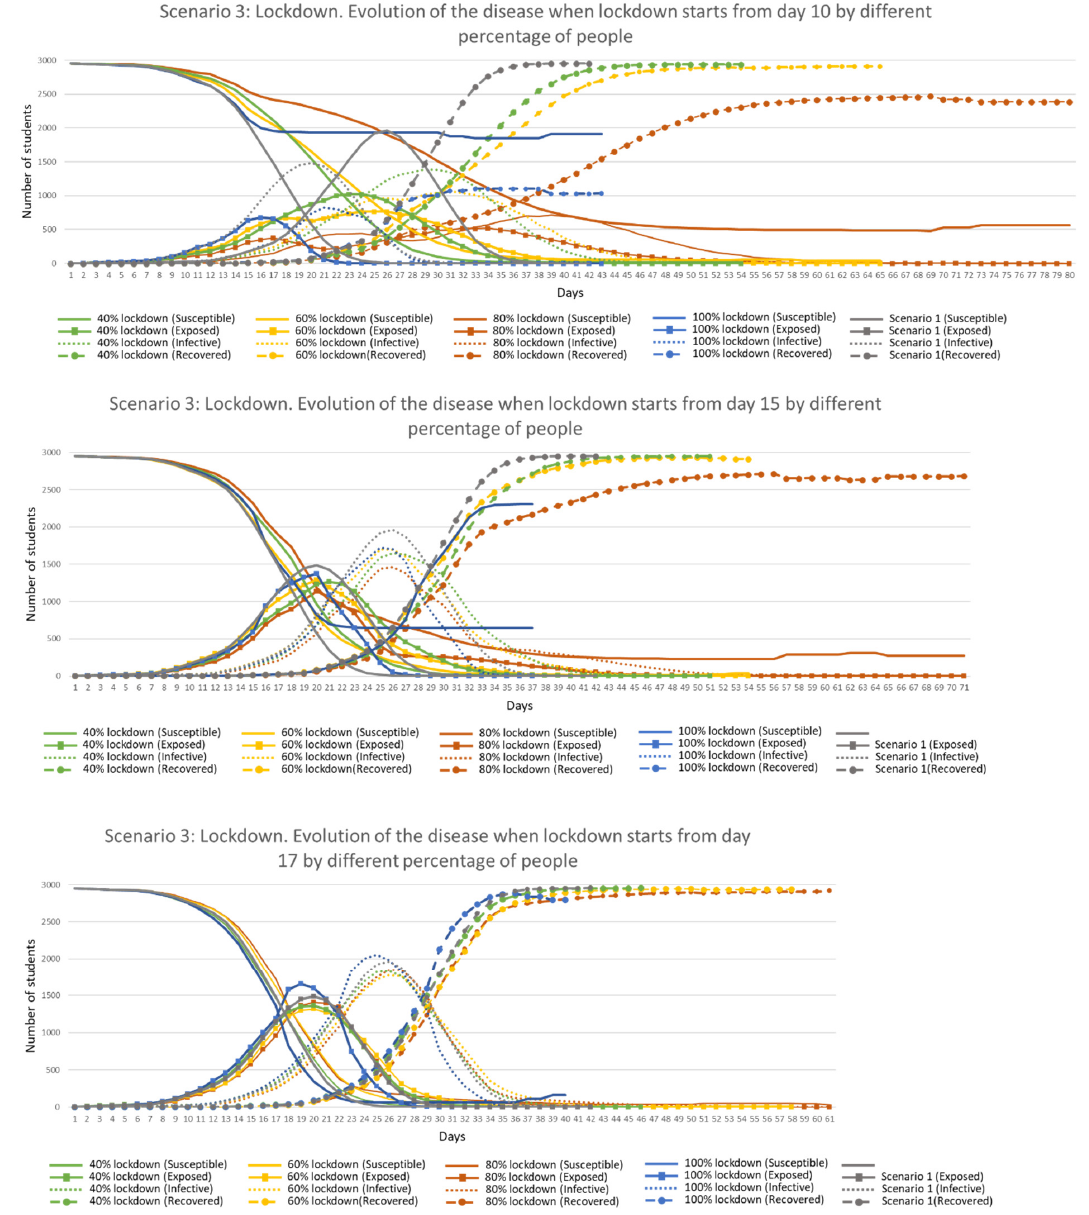
Figure A2. Comparison of the evolution of the disease between Scenarios 3 (Lockdown) against Scenario 1 (No Measures).